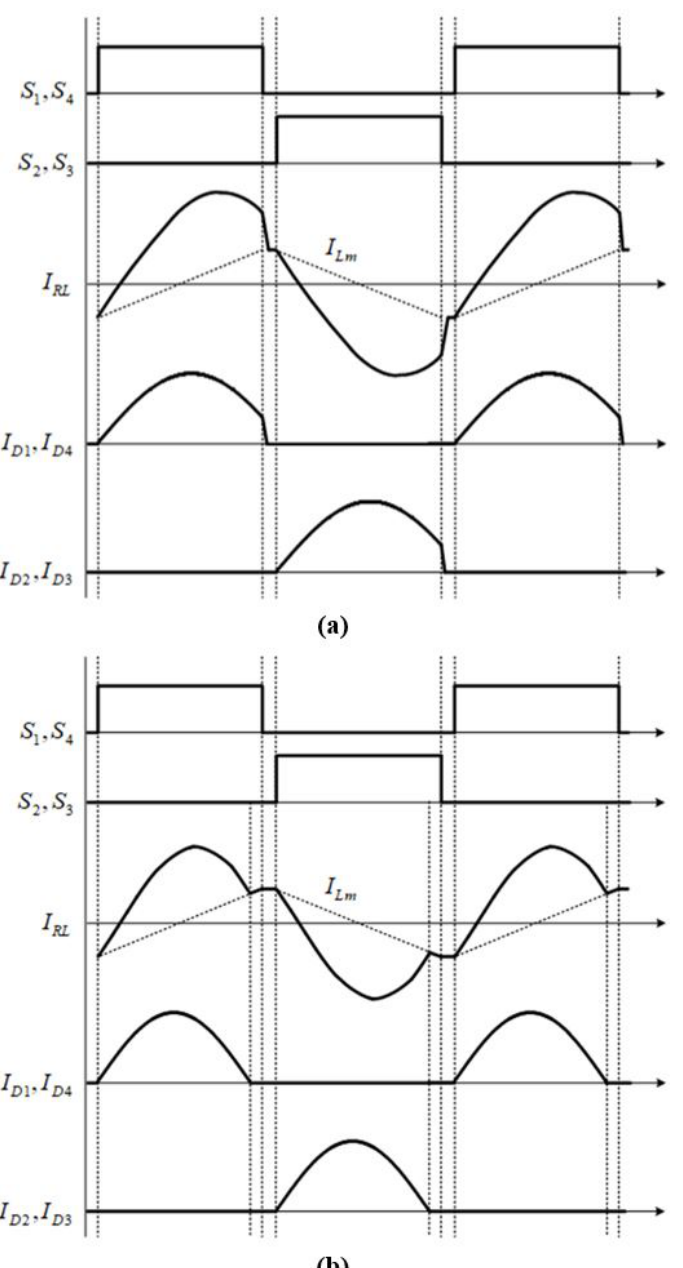
Figure 5. LLC resonant converter current waveform ( a ) inductive mode; ( b ) capacitive